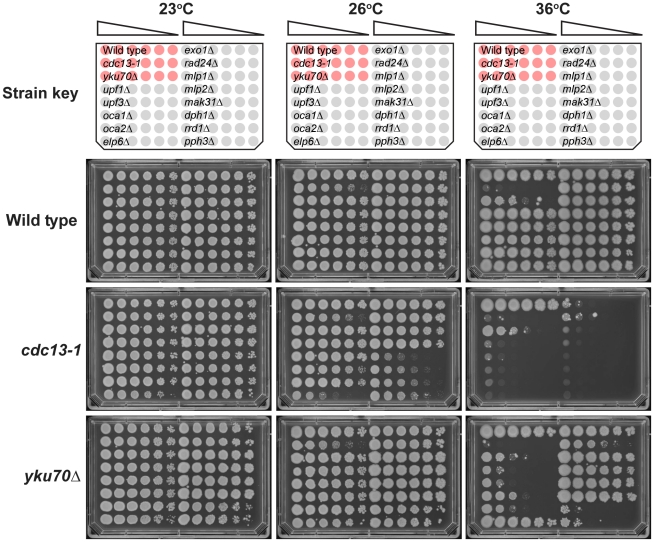
Confirmation of genetic interactions in an alternative genetic background.A selection of genes identified by QFA were combined with either the yku70Δ or cdc13-1 mutations in the W303 genetic background and assessed for growth by manual spot test. Strains were cultured to saturation in 2 ml YPD at 23°C, a six-fold dilution series generated and spotted onto YPD. Strains were incubated at the indicated temperatures for three days before being photographed. All plates contained the reference strains 640 (wild type), 1108 (cdc13-1) and 1412 (yku70Δ), indicated as red cultures in the key. The “Wild Type” single mutant strains assessed were: 6656, 6811, 3622, 3653, 6620, 1273, 659, 6862, 6927 6951, 6963, 6692 and 6632. The cdc13-1 double mutant strains assessed were: 6810, 6814, 3624, 3655, 6614, 1296, 1258, 6860, 6928, 6865, 6967, 6694 and 6396. The yku70Δ double mutant strains assessed were: 6808, 6812, 4290, 4296, 6628, 1409, 1284, 2413, 2415, 6968, 6971, 6776 and 6763. Growth at other temperatures is shown in Figure S2.